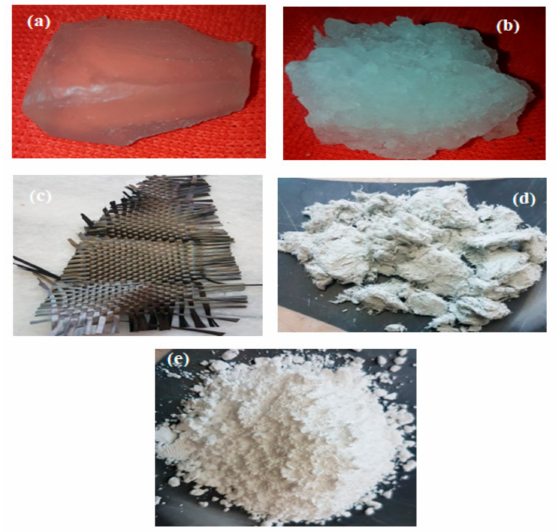
Figure 1. Physical form of ( a ) EPDM-Esprene 501 A, ( b ) EPDM-Keltan ® 4869C DE, ( c ) Carbon fiber fabric (CFF, graphite fiber), ( d ) asbestos (chrysotile), and ( e ) vulkasil-C (precipitated